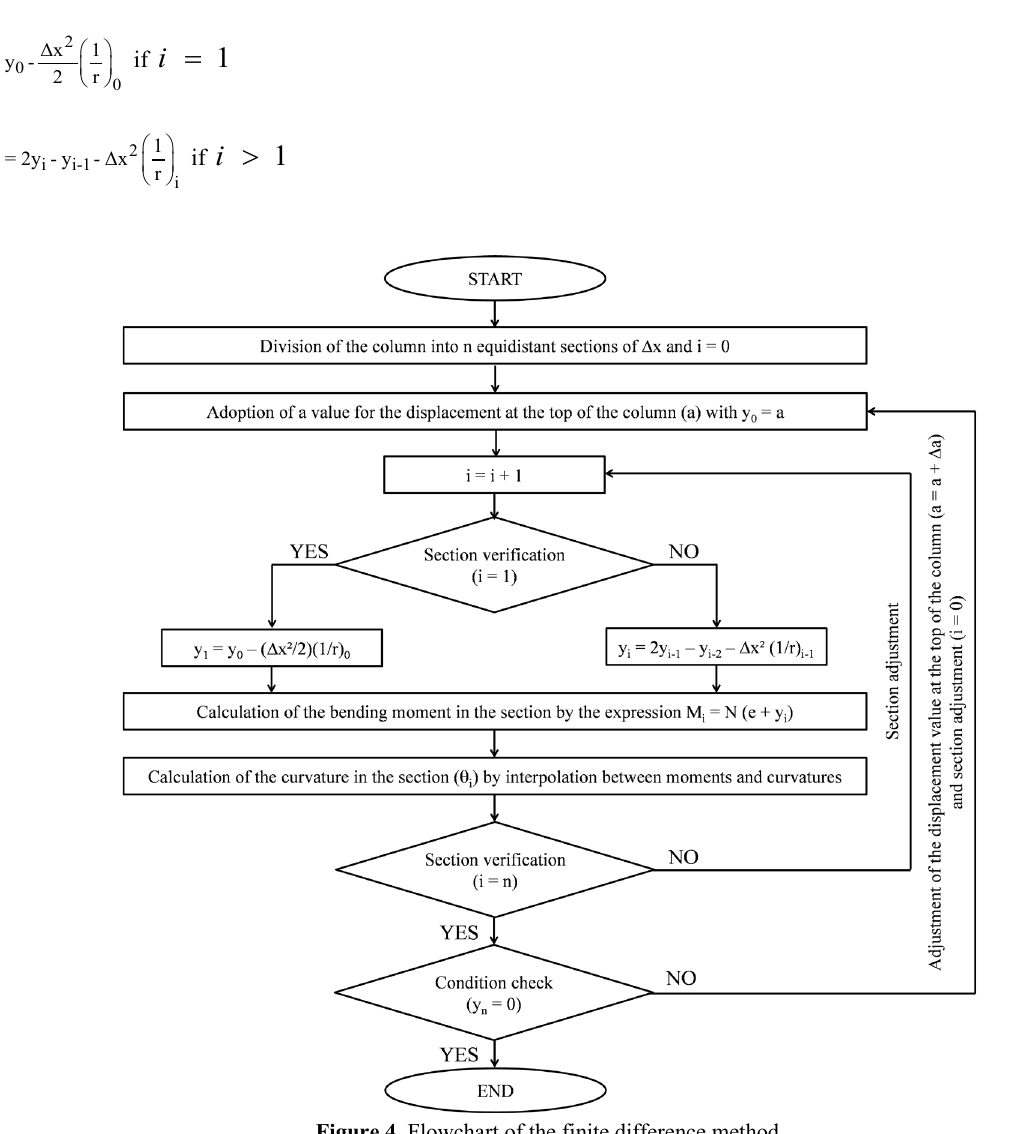
Figure 4. Flowchart of the finite difference